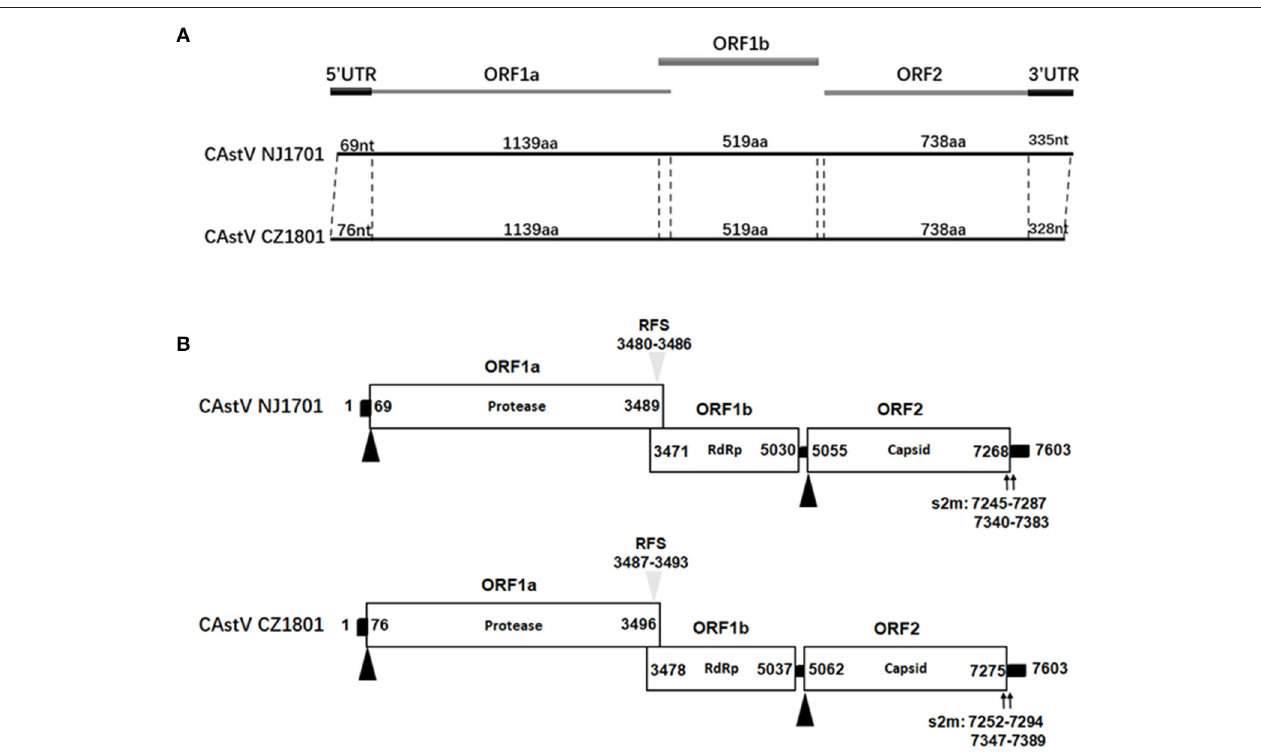
FIGURE 1 | (A) Genome organization of chicken astrovirus isolates chicken astroviruses (CAstV)/NJ1701 and CAstV/CZ1801. (B) Three open reading frames (ORFs) with their locations and the motifs typical for astroviruses are shown. The translation start sites of ORF1a and ORF2 are indicated by black triangles. The nucleotide position of the start site of the heptameric AAAAAAC (RFS) sequence is shown by gray triangles. Black bars are the untranslated regions and the 24-nt spacer between the stop and start codons of ORF1b and ORF2, respectively. ORF, open reading frame; RdRp, RNA-dependent RNA polymerase; RFS, ribosomal frameshift signal; s2m,